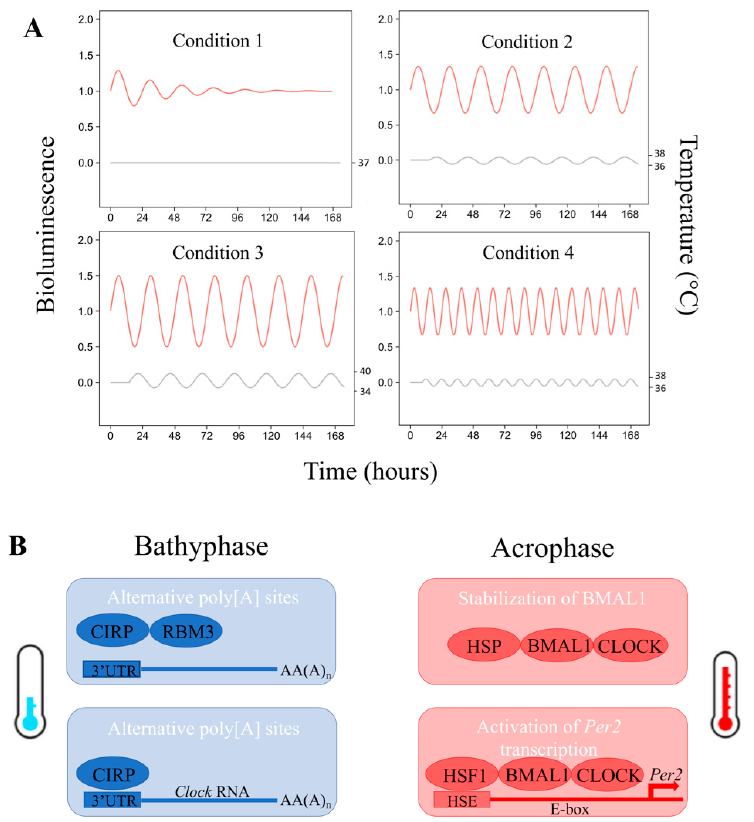
Figure 3. Molecular connection between the circadian rhythm of body temperature (CRBT) and the molecular clock. ( A ) Schematic representation of the effect of the temperature on the expression of the clock genes (e.g., Bmal1 in a model of cultured fibroblasts). Red curves represent the expression of Bmal1 quantified by bioluminescence. Grey curves represent the temperature cycles set in the incubator. From left to right and top to bottom, an example of cell culture maintained at 37 °C showing a progressive decrease of the oscillatory expression of the clock gene (Condition 1). Then followed by three examples of synchronization of the clock gene expression by three different conditions of temperature cycles: with an amplitude of 2 °C and a period of 24 h (Condition 2), an amplitude of 4 °C and a period of 24 h (Condition 3), and an amplitude of 2 °C and a period of 12 h (Condition 4) [11]. ( B ) Possible mechanisms involved in the temperature entrain- ment of molecular clocks in the peripheral tissues are depicted [36]. Cold temperature-induced RNA-binding proteins CIRP and RBM3 lengthen the 3 ′ untranslated region (3 ′ -UTR) of target RNAs by suppressing their proximal polyadenyla- tion sites. CIRP also promotes the nuclear export and translation of Clock RNA. On the other hand, warm body tempera- ture transcriptionally activates Per2 expression in an HSF1-dependent manner, whereas HSP90 post-translationally stabi- lizes BMAL1-CLOCK complex, a heterodimeric activator of the Per2 transcription. The molecular mechanism involving the temperature in the clock transcriptional loop is depicted in Figure 3B. The transcriptional effect of the temperature rhythm in- volves the cold-inducible RNA-binding protein (CIRP), a highly conserved RNA-binding